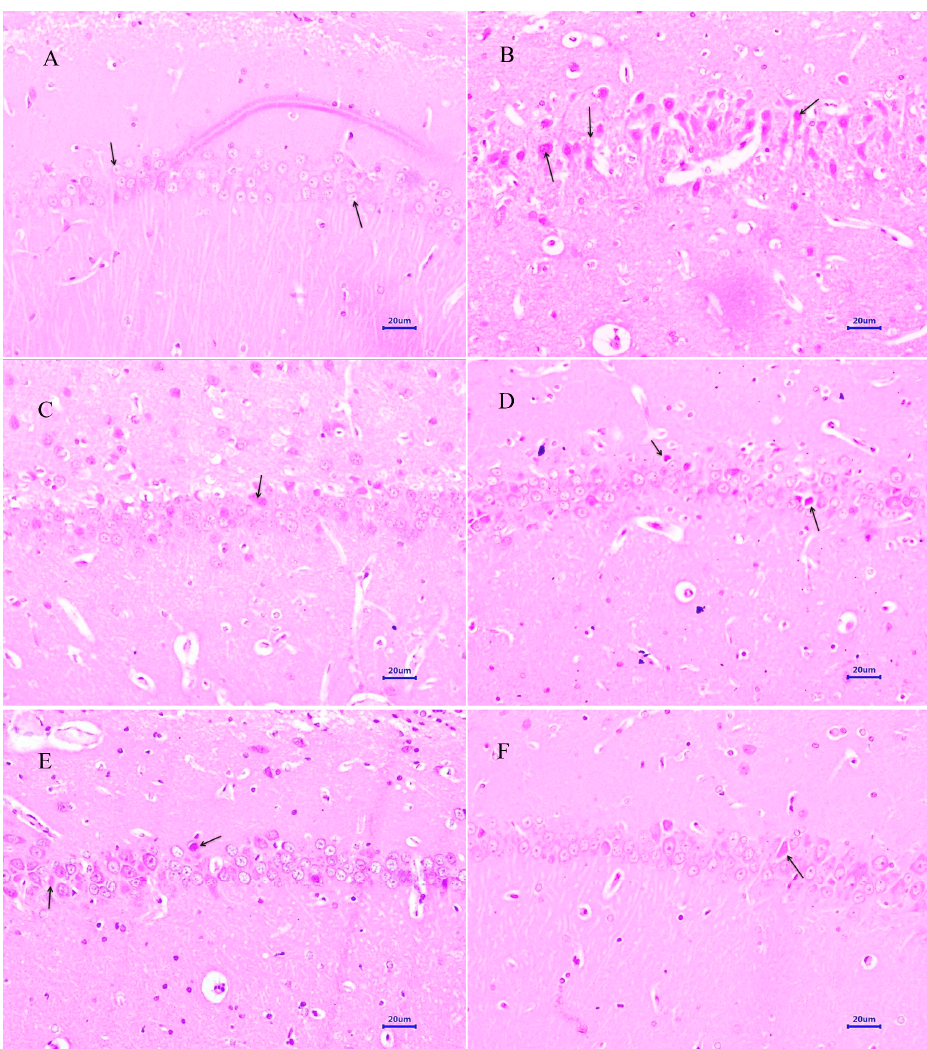
Figure 6. Effect of A β (1–42), baicalein and baicalein with memantine on H&E-stained hippocampus tissue (400×, scale bar = 20 μ m). ( A ) Normal control: displaying normal histology, normal neuronal cells in hippocampus (arrow). ( B ) Disease control: displaying multifocal reduced layer of neuronal cells (arrow) and marked neurodegeneration with pyknotic nuclei (arrow) in hippocampus. ( C ) Me- mantine 20 mg/kg: displaying mild to moderate neurodegeneration with pyknotic nuclei in hippo- campus (arrow). ( D ) Baicalein (10 mg/kg): displaying multifocal minimal to mild neurodegenera- tion with pyknotic nuclei in hippocampus (arrow). ( E ) Memantine + Baicalein (20 + 5 mg/kg): dis- playing multifocal minimal to mild neurodegeneration with pyknotic nuclei in hippocampus (ar- row). ( F ) Memantine + Baicalein (20 + 10 mg/kg): displaying mild neurodegeneration with pyknotic nuclei in hippocampus (arrow).